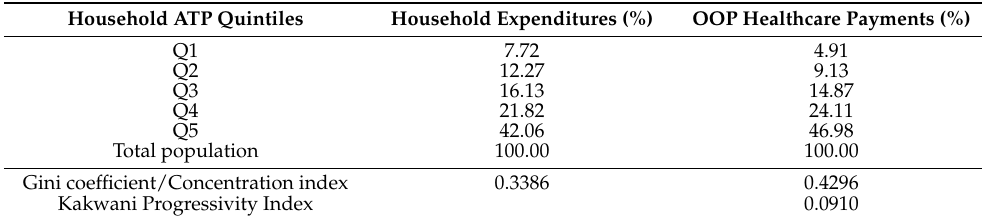
Table 2. Cumulative population shares, Gini coefficient, concentration index and Kakwani Progres- sivity Index of OOP payments for healthcare, Malaysia 2014/2015.